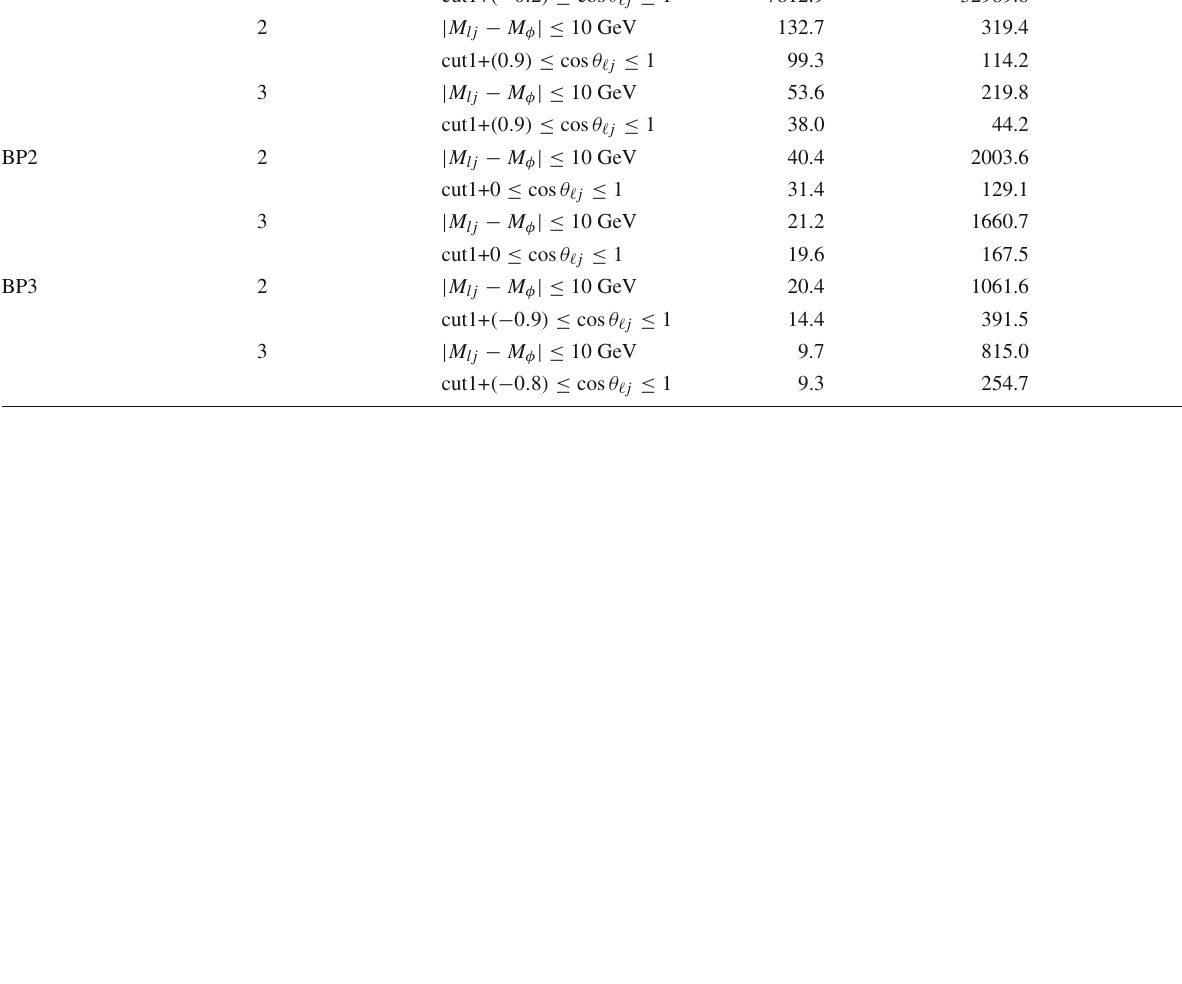
Table 9 Signal-background analysis for leptoquark ( S + 4 Bench-mark points